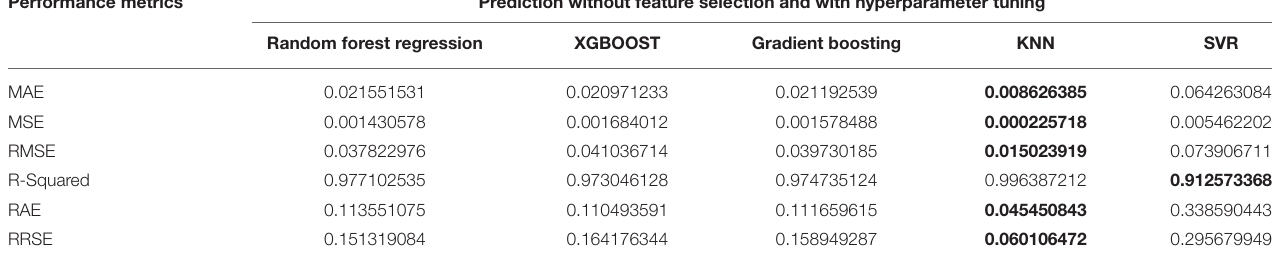
TABLE 5 | Prediction without Feature Selection and with hyperparameter tuning. Performance metrics Prediction without feature selection and with hyperparameter tuning Random forest